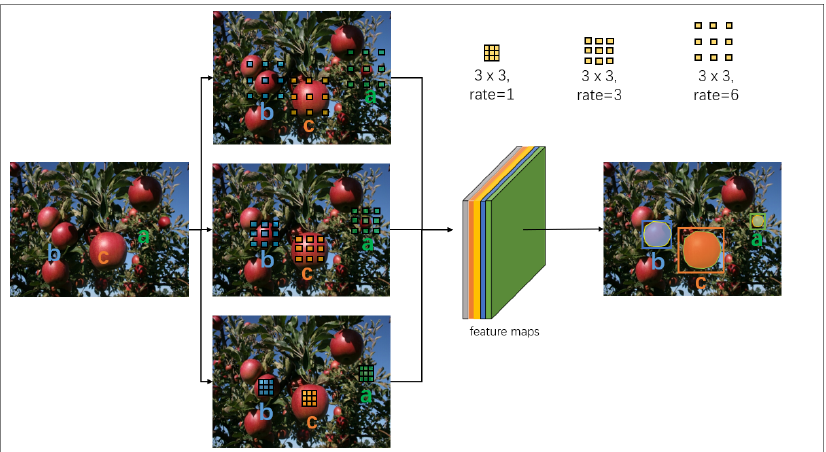
Figure 6. The ASPP adopts the dilation convolution with different dilation rates to encode the multi-scale information of